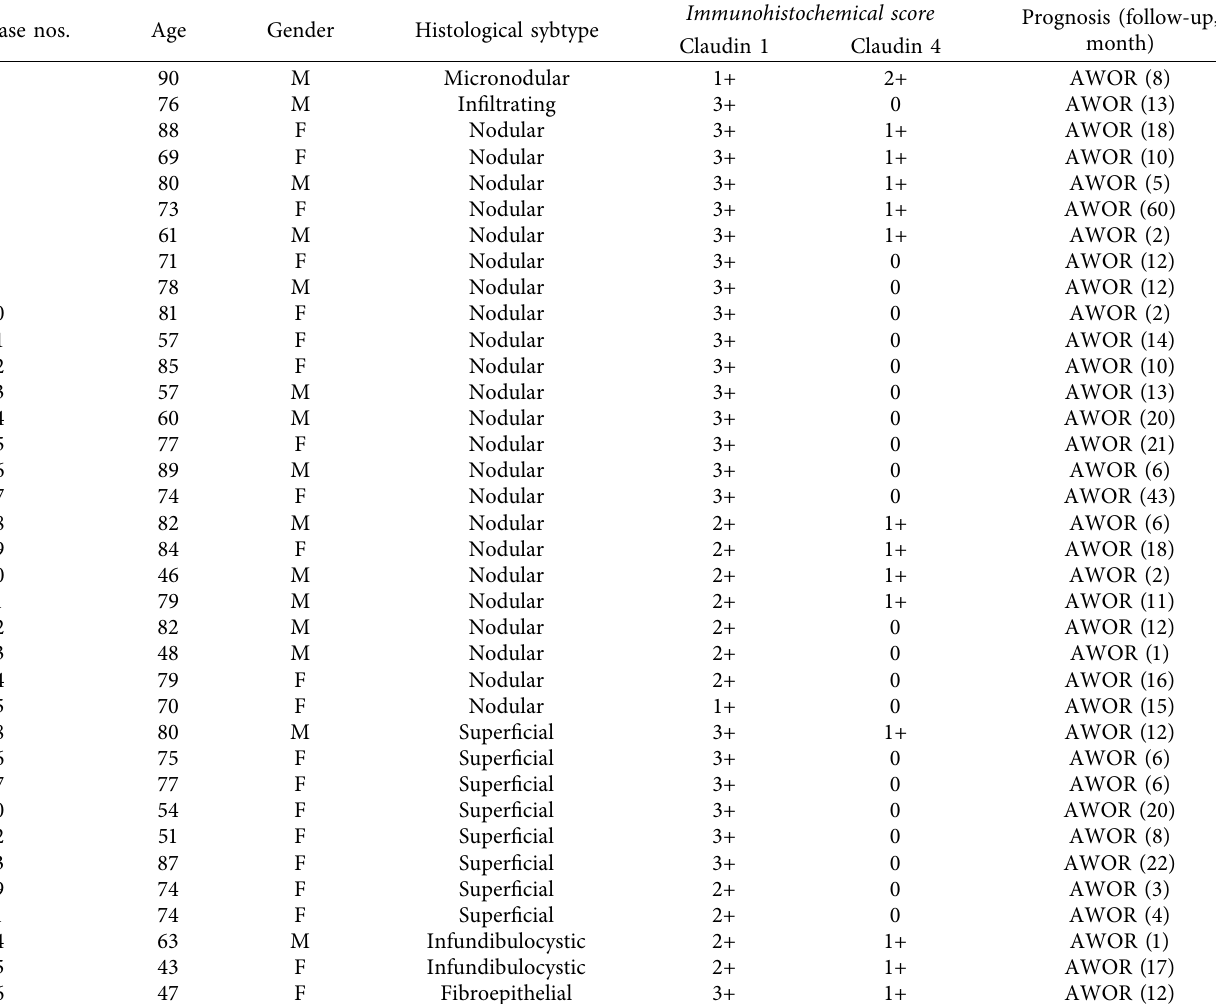
Table 2: Clinicopathological features and IHC scores of claudin 1 and 4 in basal cell carcinoma. Case nos.